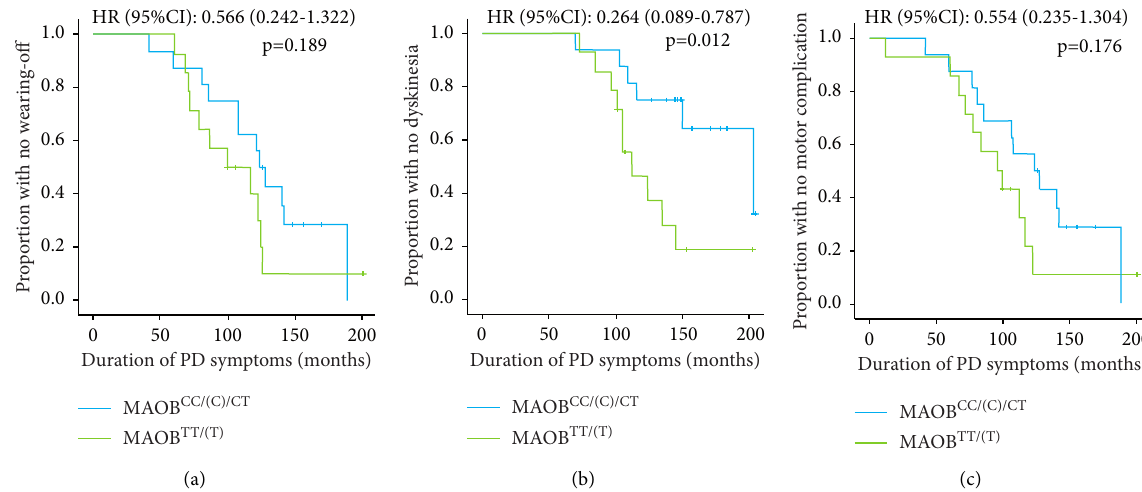
Figure 2: Risk of levodopa-induced motor complications with respect to genotypes in the MAOB rs1799836 polymorphism. Kaplan–Meier curves show the association between MAOB rs1799836 genotypes ( MAOB CC/(C)/CT genotypes: associated with low/intermediate enzyme activity in the brain (blue line); MAOB TT/(T) genotypes: associated with high enzyme activity in the brain (green line)) and the risk for wearing-off (a), levodopa-induced dyskinesia (b), and any motor complication (c). Hazard ratios (HR) with 95% confidence intervals (95% CI) and p values are from univariate Cox proportional hazard models with those genotypes associated with high MAOB activity ( MAOB TT/ (T) ) adopted as the reference